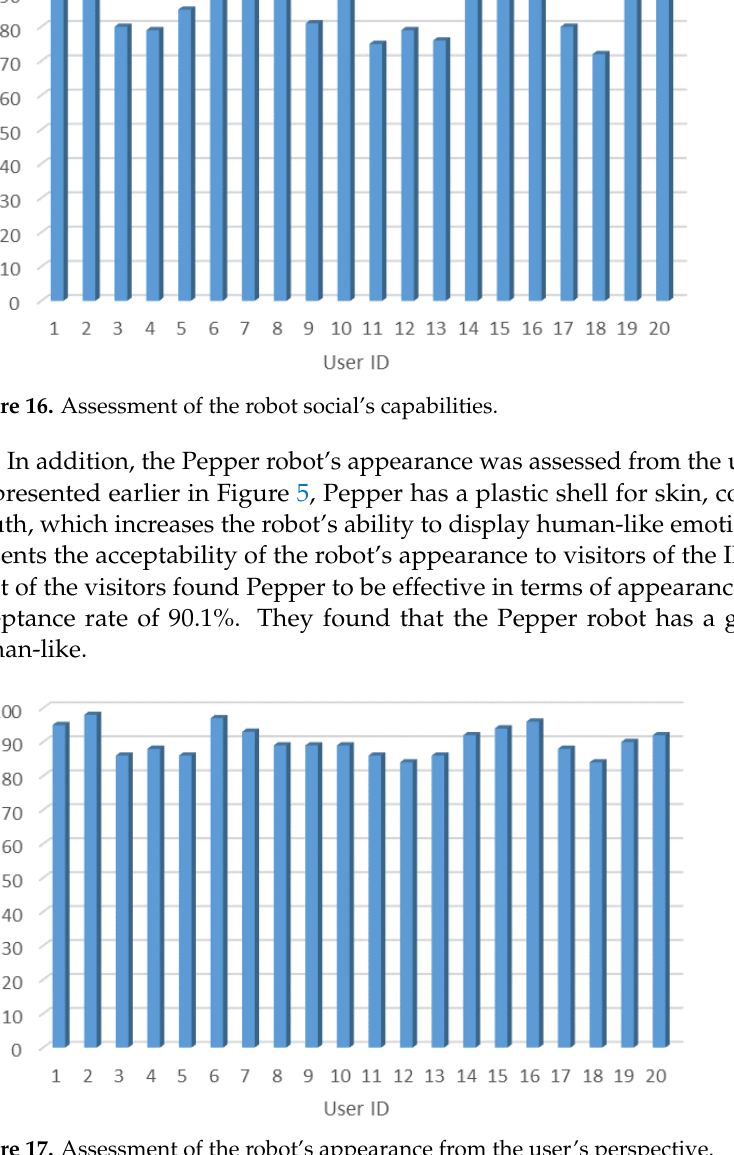
Figure 17. Assessment of the robot’s appearance from the user’s perspective.